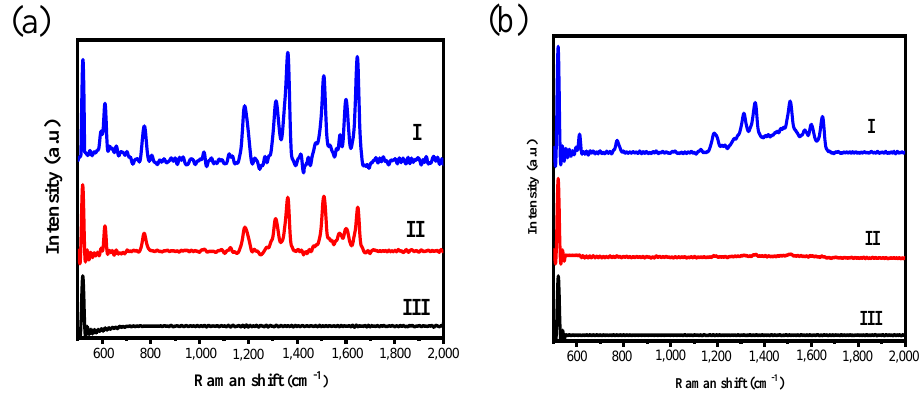
Figure 9. SERS spectra of R6G solutions with different concentrations deposited on Au-coated PC films with silica particle sizes of ( a ) 316 and ( b ) 354 nm. (I) R6G concentration 5 × 10 − 3 M, (II) 1 × 10 − 5 M, (III) 1 × 10 − 6 M.